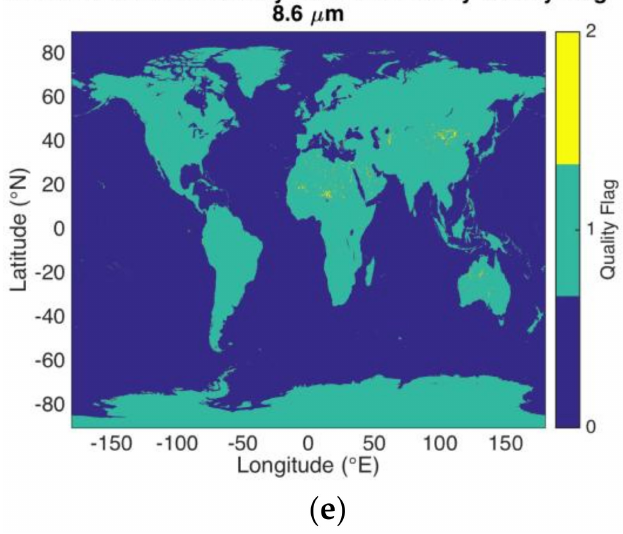
Figure 2. January 2007 CAMEL 8.6 um emissivity uncertainty ( a ) total estimate; ( b ) spatial component; ( c ) temporal component; ( d ) algorithm component; and ( e ) total uncertainty quality flag which is defined in Table